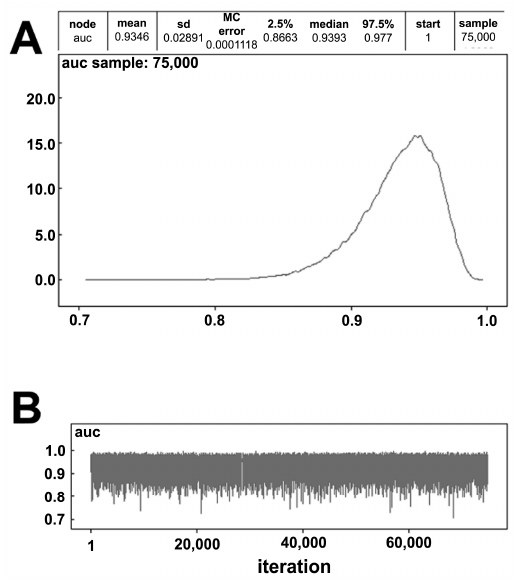
Figure 4. ( A , B ) Graphical representation of the Markov chain Monte Carlo (MCMC) model sensitivity simulation over 75,000 iterations. Table 3. ANOVA test revealing a statistically-significant distribution of FKBP51 positivity between p16 INK4a -negative and -positive groups ( p = 0.001).